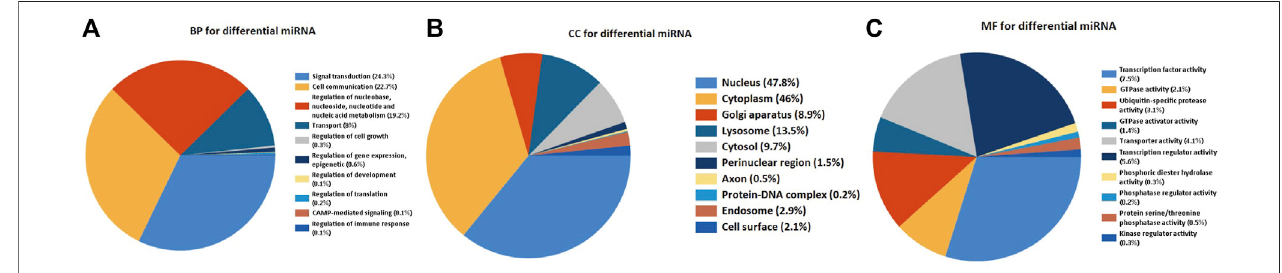
Frontiers in Genetics |